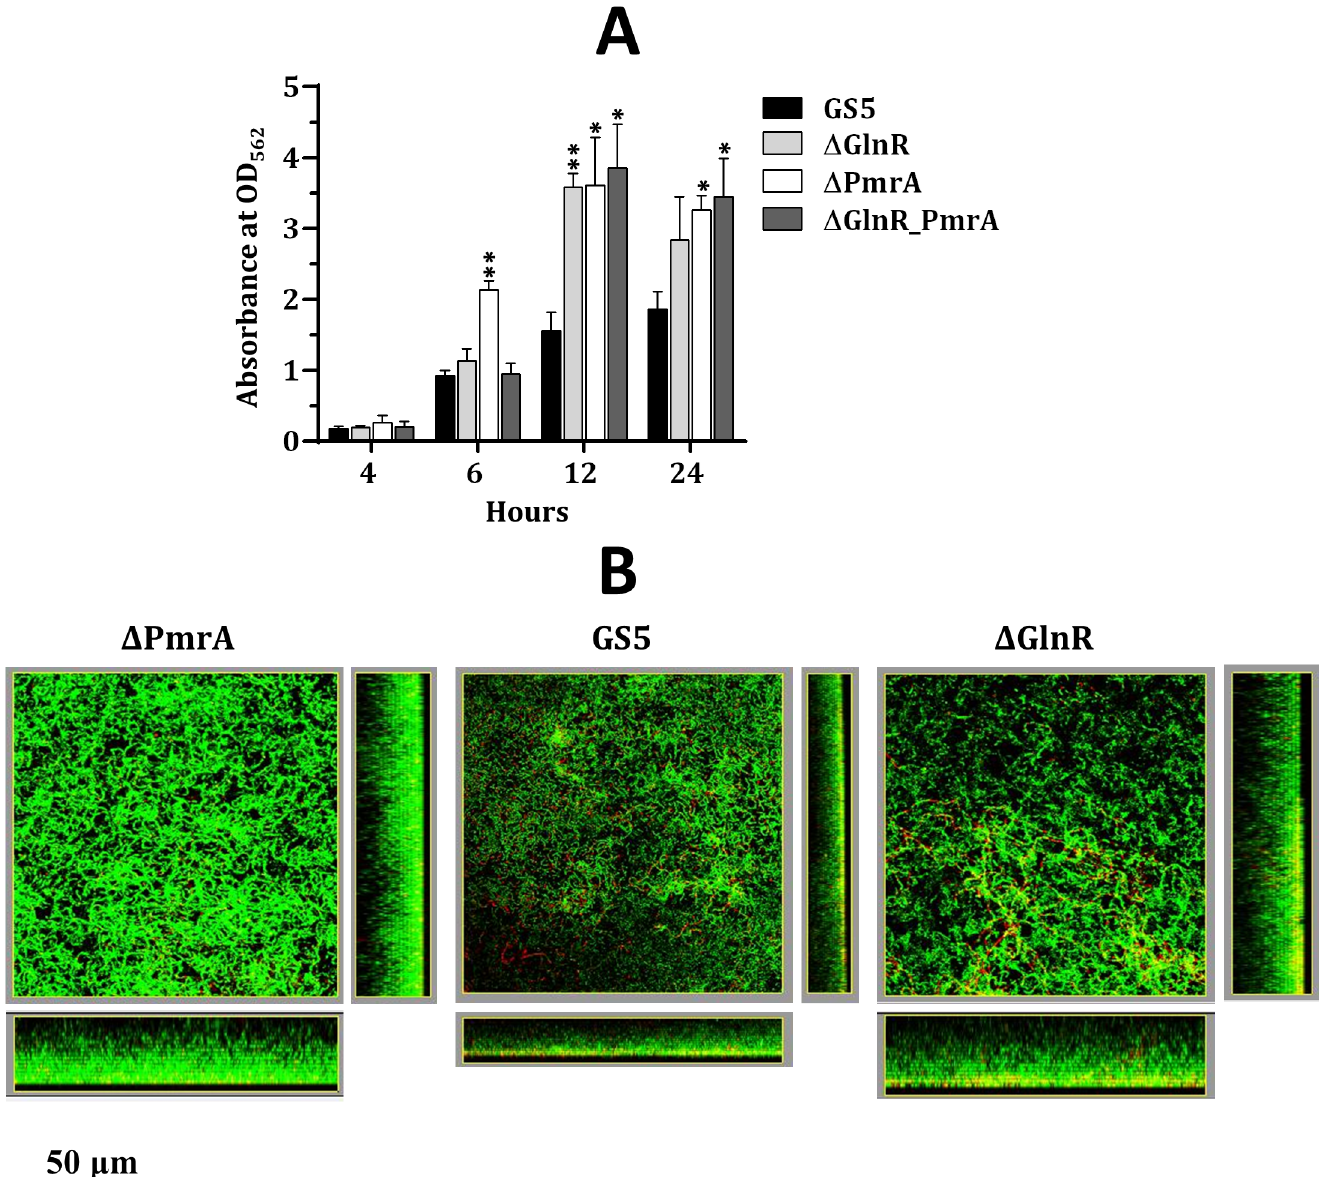
Fig 6. The biofilm formation of S . mutans GS5 and its derivatives. (A) The static biofilm formation. Cells were grown in BM containing 10 mM glucose. The amount of the crystal violet retained by the biofilm cells was measured by spectrophotometry. Values shown are the mean and standard deviation of three samples. Significant differences between GS5 and the mutant strains at each time point were determined by Student ’ s t test. ** , P < 0.001; * , P < 0.01. (B) Structures of biofilms formed by wild-type S . mutans GS5 and its derivatives in the flow cell system. The biofilms were grown in BHI for 16 h. The biofilms were treated with the SYTO 9/PI fluorochrome reagents and visualized by CLSM. The live cells (green fluorescence) and dead cells (red fluorescence) are shown. Both the top view and side view of the biofilms are